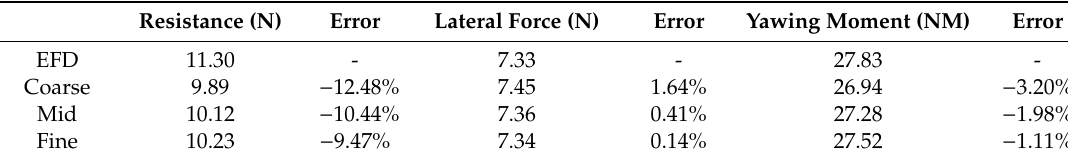
Table 4. Grid convergence of the resistance in CASE DA4.